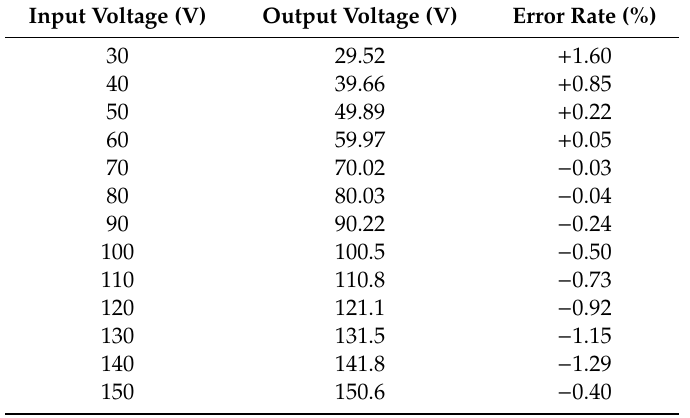
Table 2. Measured input and output amplitudes of the main control circuit with error rates.